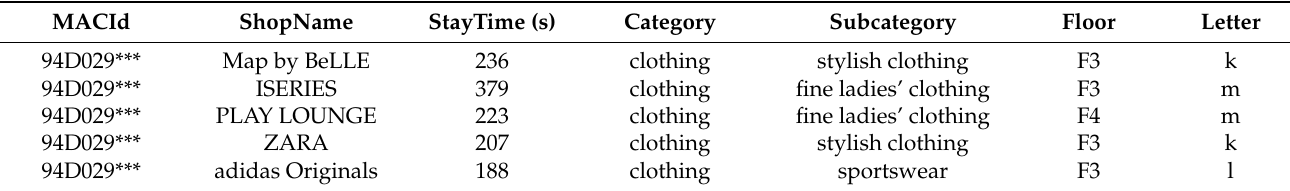
Table 5. Extended semantic trajectory